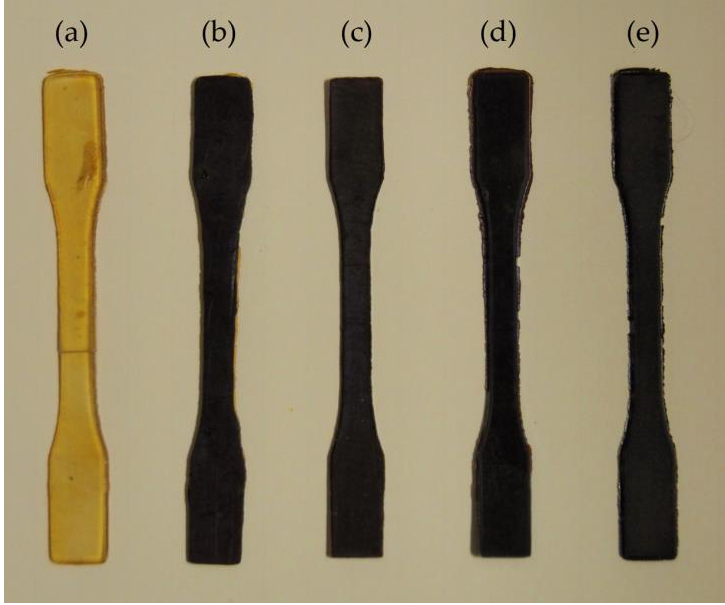
Figure 1. 3D printed specimens: ( a ) unfilled; ( b ) 0.5% AgAcr; ( c ) 1% AgAcr; ( d ) 2% AgAcr; and ( e ) 1% Figure 1. 3Dprintedspecimens: ( a )unfilled; ( b )0.5%AgAcr; ( c )1%AgAcr; ( d )2%AgAcr; and( e AgMAcr.